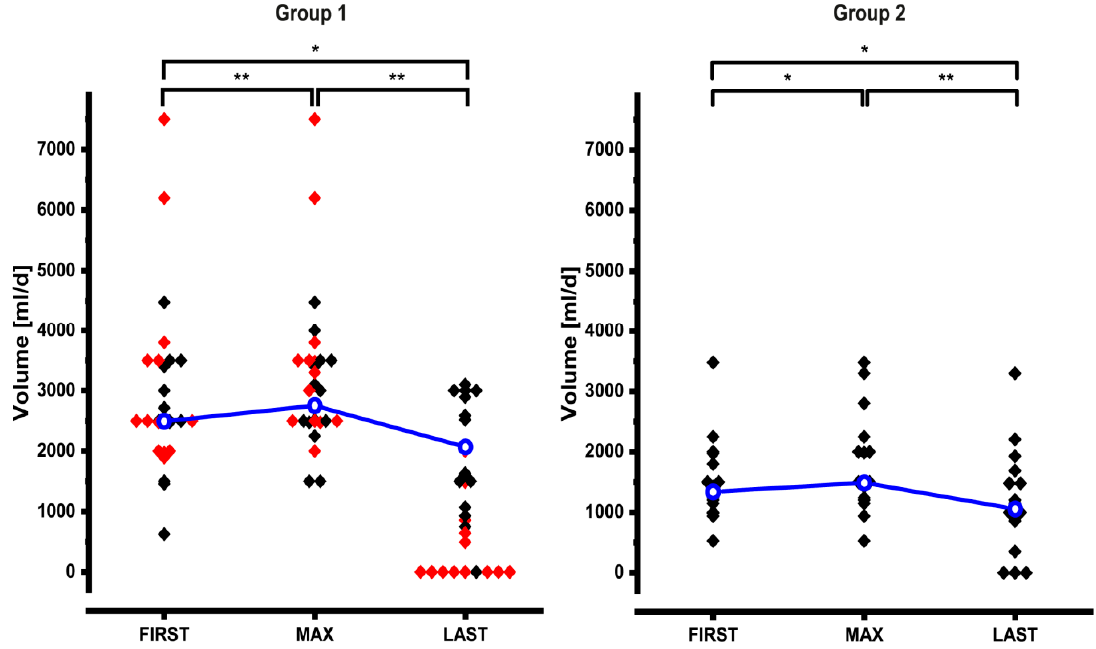
Figure 3. Dynamic changes of volume support in group 1 and group 2 patients. In group 1, 11 patients had reconstructive surgery and 2 patients received teduglutide between MAX and LAST, they are indicated as red symbols and they are not included in the statistical analysis (median values and significant differences) at time point LAST. Median values are connected by the blue line. See text for details (* p < 0.05; ** p < 0.01).